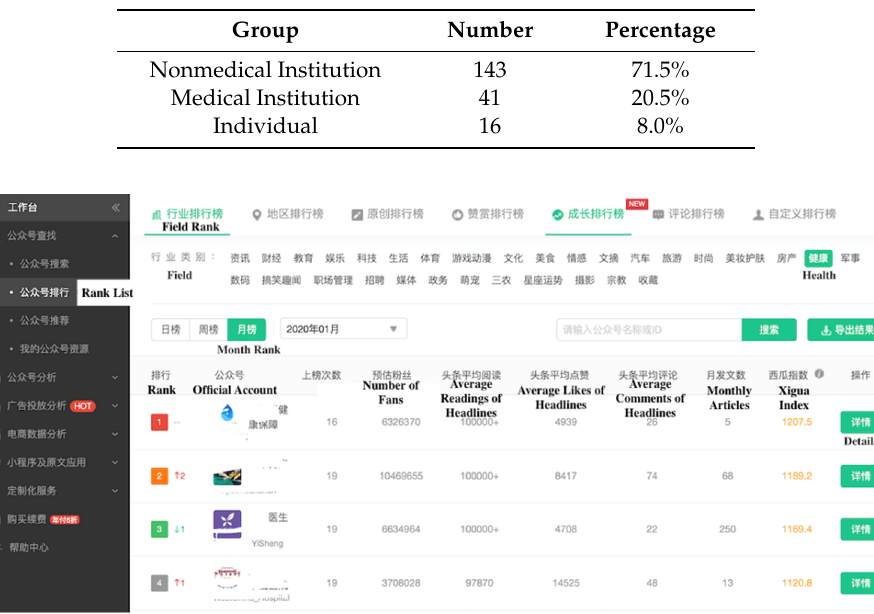
Figure 2. Screenshot of the rank list page. Some important nouns and items were translated into English.